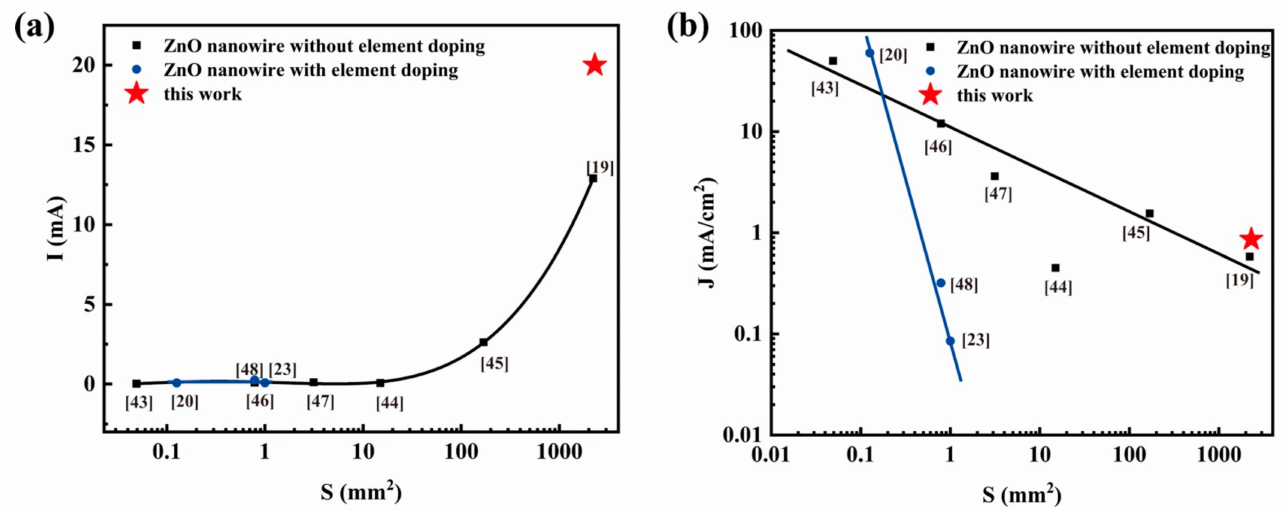
Figure 7. Comparison in the ( a ) emission current and ( b ) corresponding current density of nanowires reported in this paper and that reported in the literature (References given with data in square